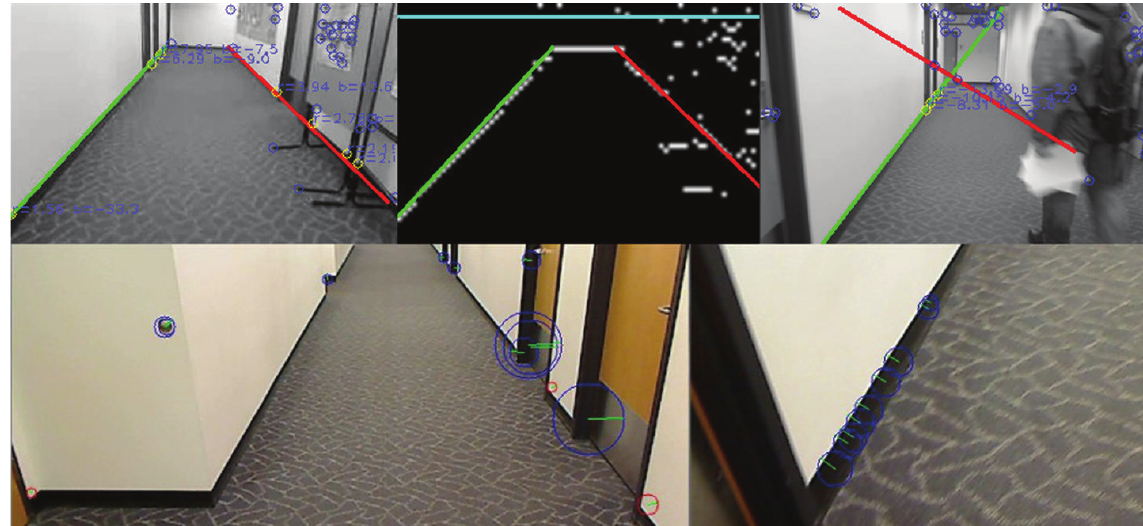
Figure 3: Initial stages after filtering for line extraction, in which the line segments are being formed. Note that the horizontal lines across the image denote the artificial horizon for the MAV; these are not architectural detections, but the on-screen display provided by the MAV. This procedure is robust to transient disturbances such as people walking by or trees occluding the